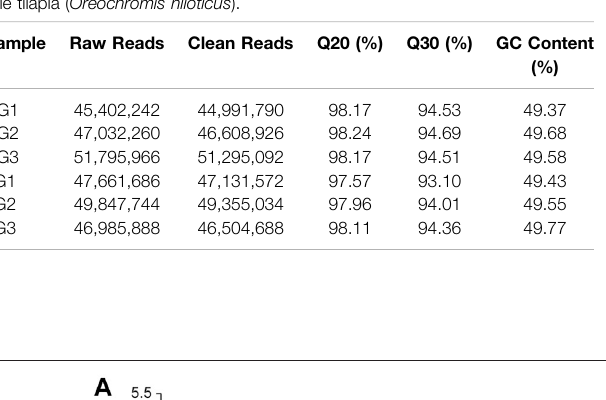
Frontiers in Genetics |